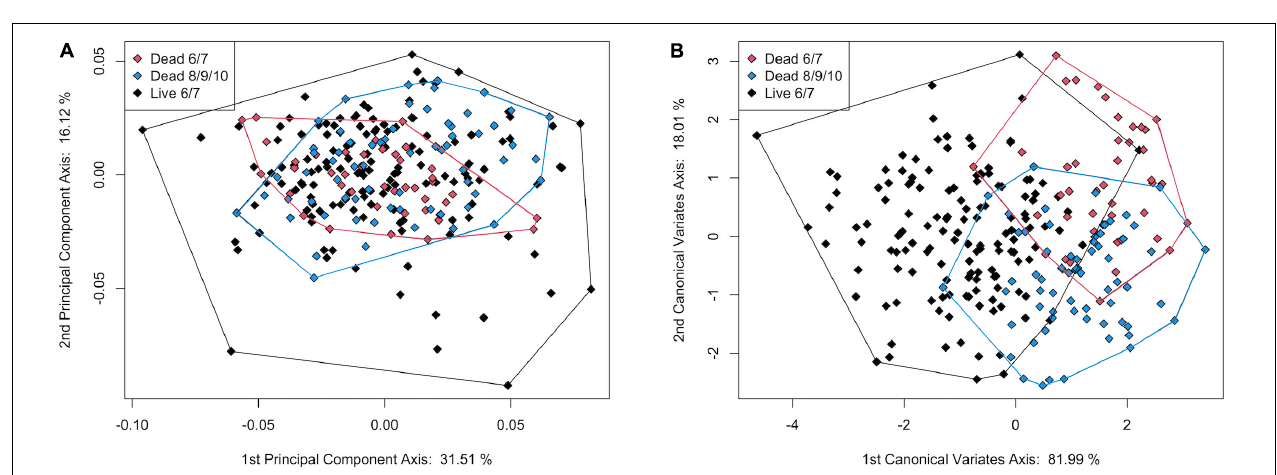
FIGURE 9 | Regression scores vs. Log(Centroid Size) for (A) live and dead specimens from transects 6 and 7; (B) live, dead from transects 6 and 7, and dead from transects 8, 9, and 10.